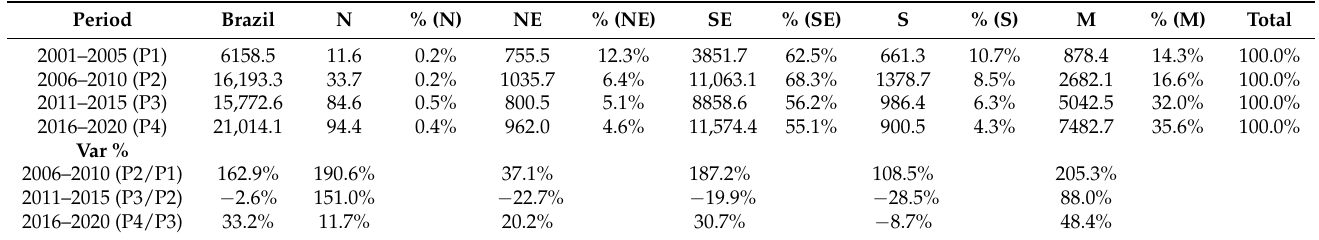
Table 2. Average five-year production of hydrous ethanol in Brazil, in thousand cubic meters, by the 5 major geographic regions, and their respective shares in the total supply. Source: own calculation with data from